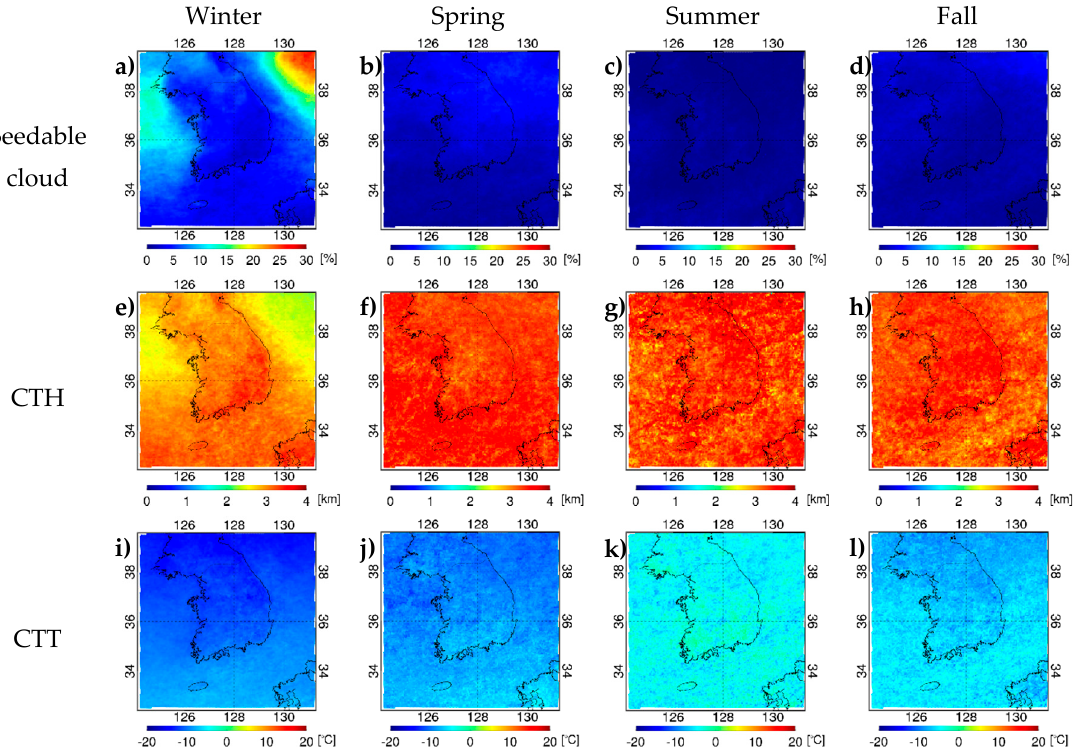
Figure 5. Frequency distribution of ice phase seedable clouds ( a – d ) and cloud characteristics (CTH: ( e – h ), CTT: ( i – l )) around the Korean Peninsula.